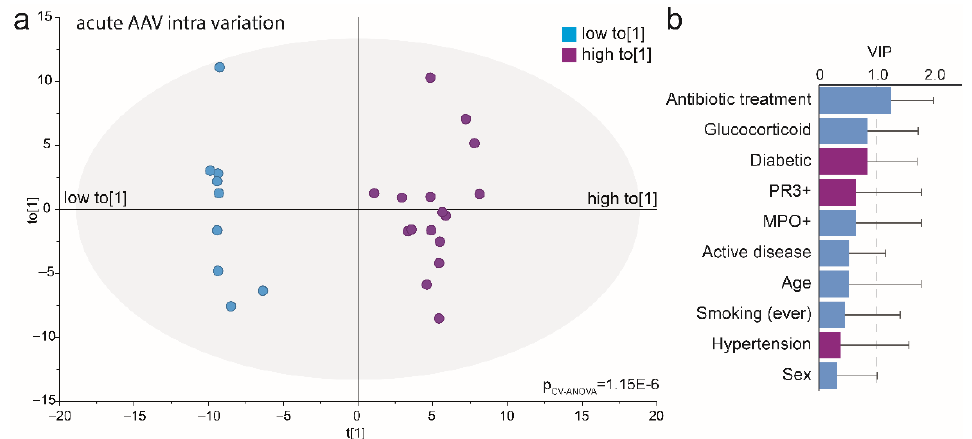
Figure 7. Multivariate analysis of acute AAV patient’s saliva microbiota. ( a ) Loading scatterplot based on an OPLS-DA model comparing acute AAV subgroups based on the intra-variation